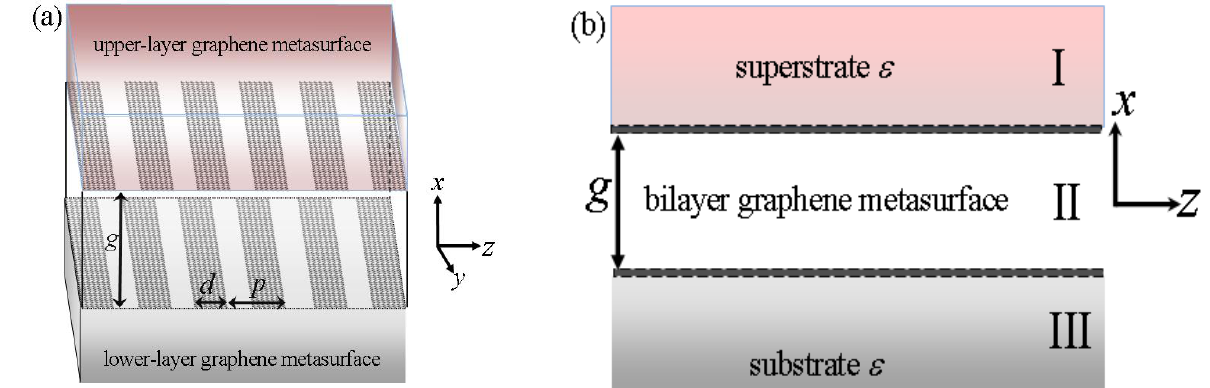
Figure 1. ( a ) The schematic diagrams of the bi-layer grapehene metasurfaces which are deposited on the same superstrate and substrate medium ε . The upper- and lower-layer graphene metasurface has the same width d and period p . The bi-layer graphene metasurface is separated by an air gap with depth of g . ( b ) The cross-section views of the bi-layer graphene metasurfaces on x–z plane. The whole structure is divided by three different regions, as labeled by I, II, and III, for the studies on its dispersion theory.